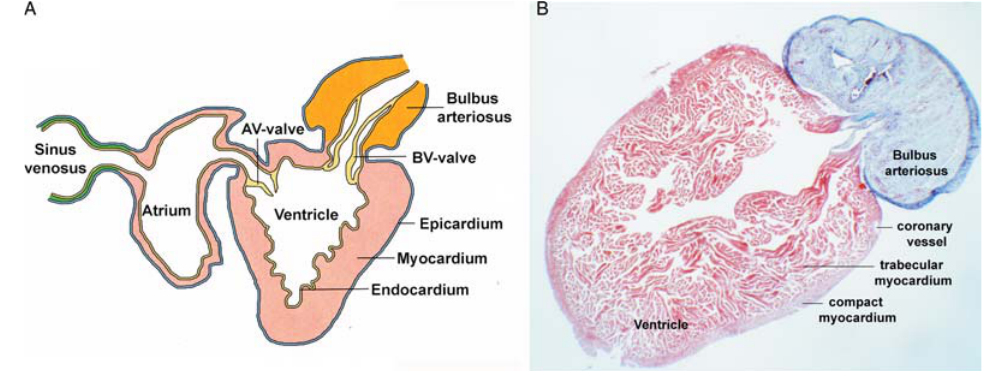
red whereas nonmuscle tissue and extracellular matrix in blue. Note the trabecular layer, which is extensive in the adult zebrafish heart, while the compact layer makes only a minor fractor of the total mass of the ventricular wall. Rarely coronary vessels are observed in the compact layer